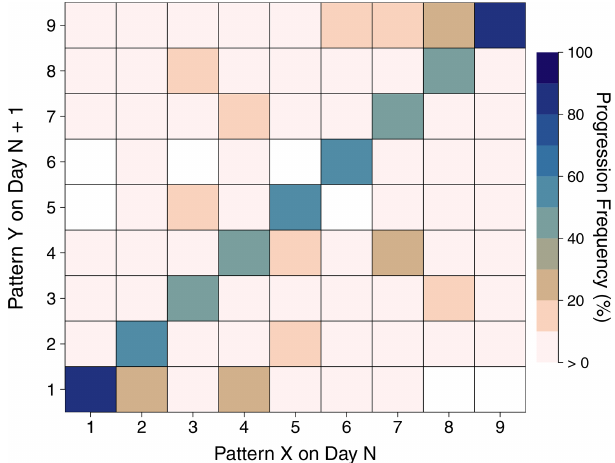
Figure 3. Timing of when the nine melt patterns occur within a melt season, plotted across all melt seasons. The x axis indicates how far through the melt season a pattern occurs, expressed as a percentage of the respective season’s full length. The y -axis values are stacked to indicate the relative occurrence of each pattern. The same data are plotted against calendar dates in Fig. S6.